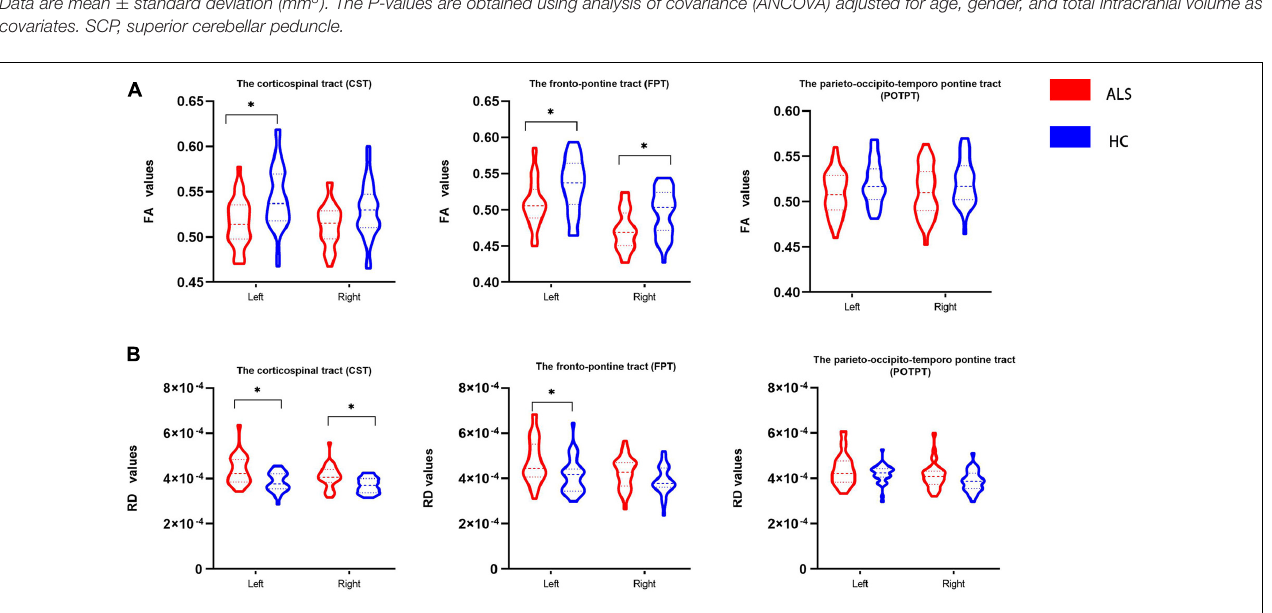
FIGURE 3 | The violin plot depicts the diffusion measures from the region of interest analysis of ALS patients and healthy control groups. The blue color represents healthy controls (HC), and the red represents ALS patients. Inner violin plot shows the quartile, median. Asterisk indicates significance after Bonferroni correction. (A) Comparison of FA values between groups. (B) Comparison of RD values between